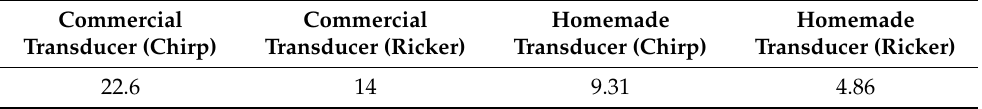
Figure 8. B-scan images generated of the test sample using different transducers and excitation pulses. ( a ) Commercial transducer with Ricker wavelet, ( b ) in-house transducer with Ricker wavelet, ( c ) commercial transducer with chirp code, and ( d ) in-house transducer with chirp code. Table 2. SNR comparison in all transducer